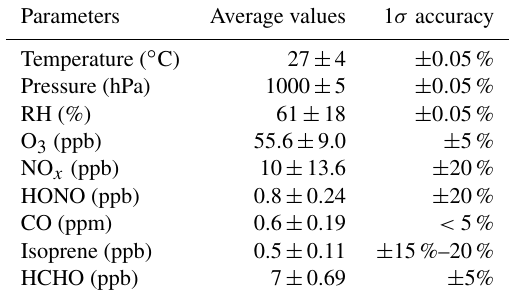
Table 2. Average daytime results of observed meteorological pa- rameters and trace gas concentration in the Wangdu campaign from 10 June to 6 July